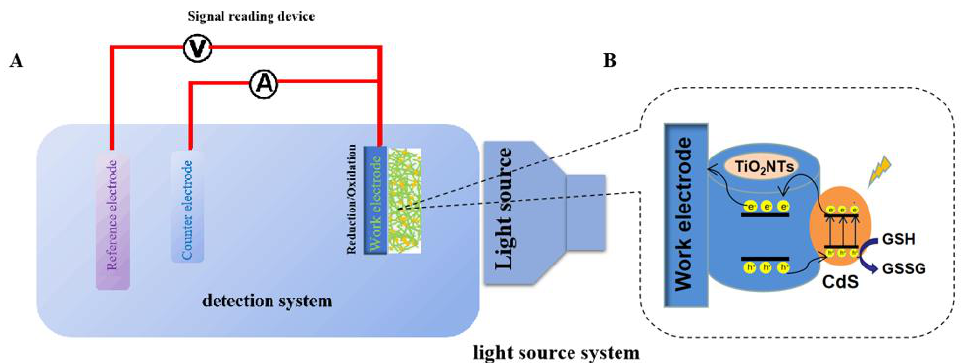
Figure 7. Schematic illustration of the PEC process for GSH detection by the CdS-TiO 2 NTs electrode biosensor (( A ) is the detection system and ( B ) is the work electrode).